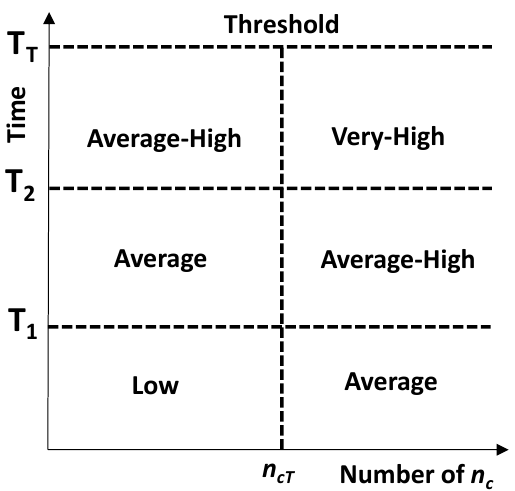
Figure 6. Criteria of UX scoring ( w ( w i ) of clicks n c (UX scoring matrix).